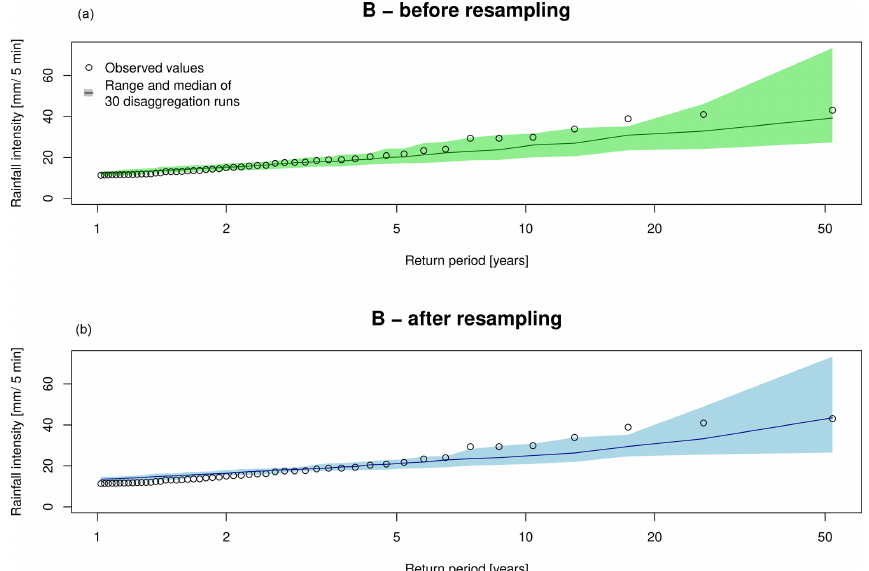
Figure 12. Extreme rainfall values for D = 5min for station Osnabrück based on 30 disaggregation realisations with method B before (a) and after (b) the